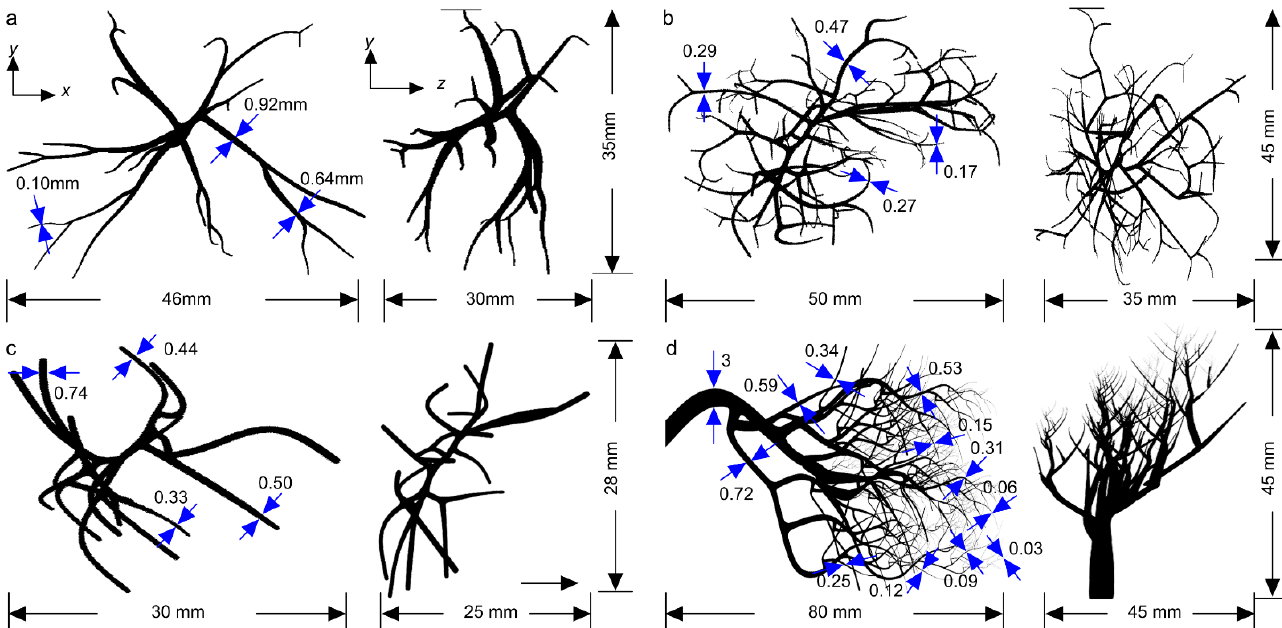
Figure 2. Three-dimensional vasculature phantom model examples developed using Blender. ( a ) Example 1, ( b ) example 2, ( c ) example 3, and ( d ) example 4. Three-dimensional model files are available in the data availability statement.